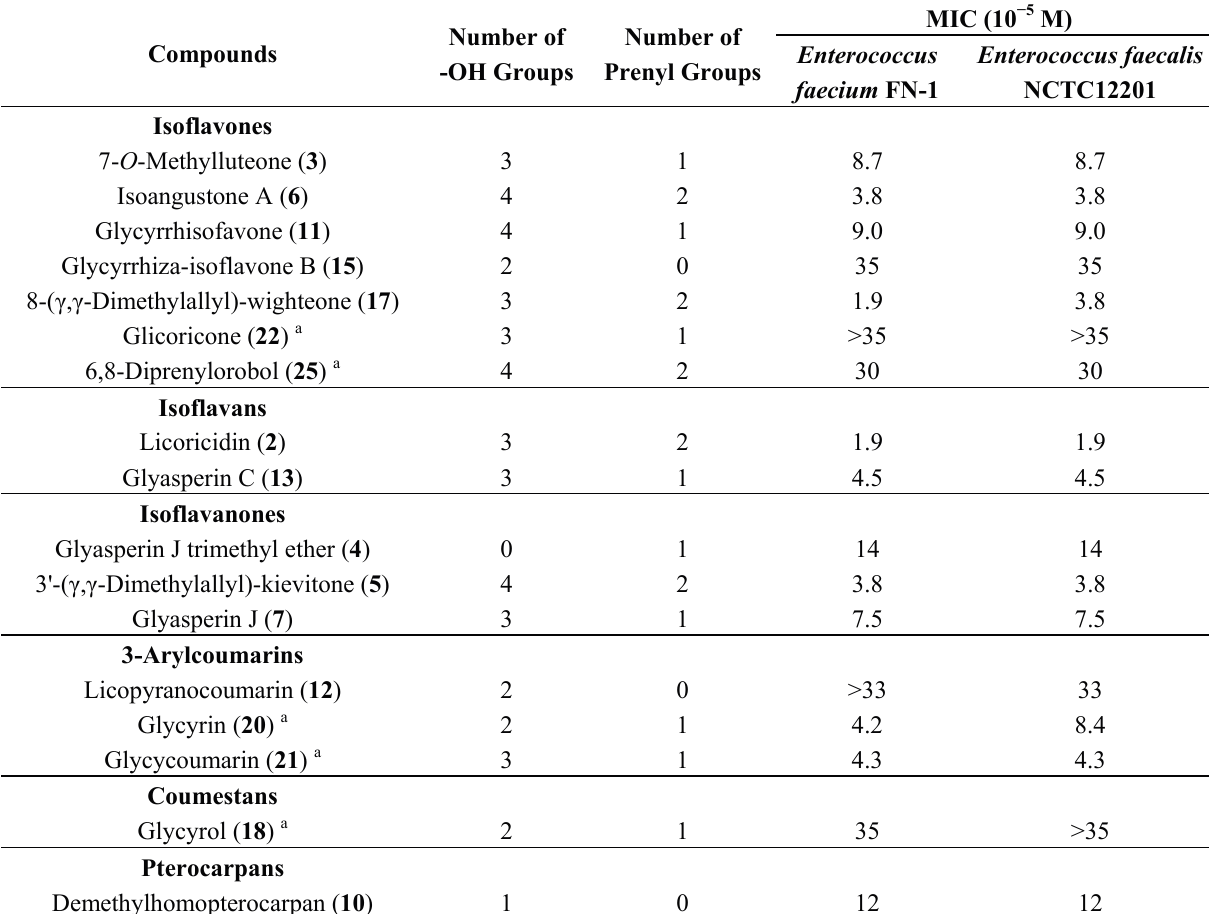
Table 2. Antibacterial effects of licorice phenolics on Enterococci (estimated minimum inhibitory concentrations, MIC) a